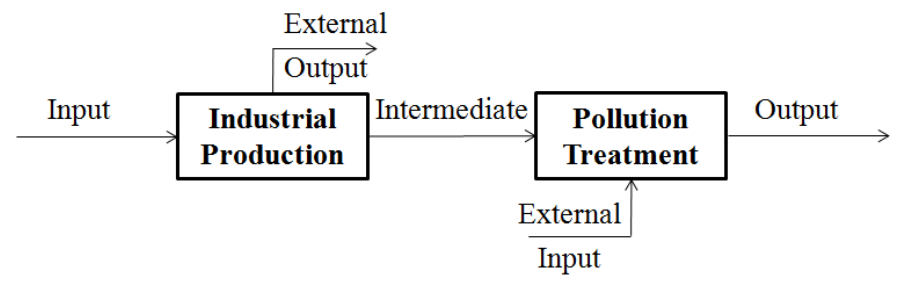
Figure 1. The structure of the industrial system, with two-stage processes.